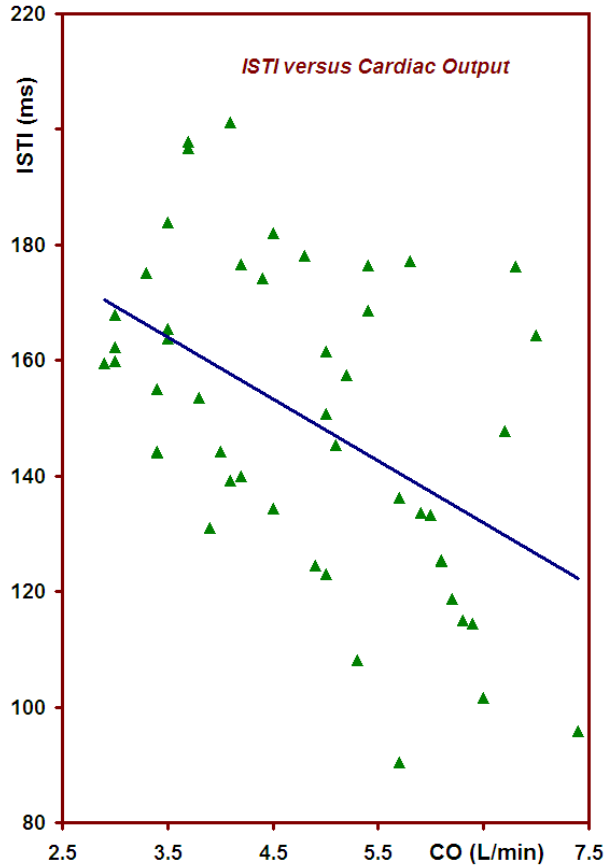
Fig.3: A significant relationship between the Initial Systolic Time Interval (ISTI) and the Cardiac Output (CO) was found before and after intravenous administration of 2x250 ml of a Gelofusine® solution in two steps of 250 ml